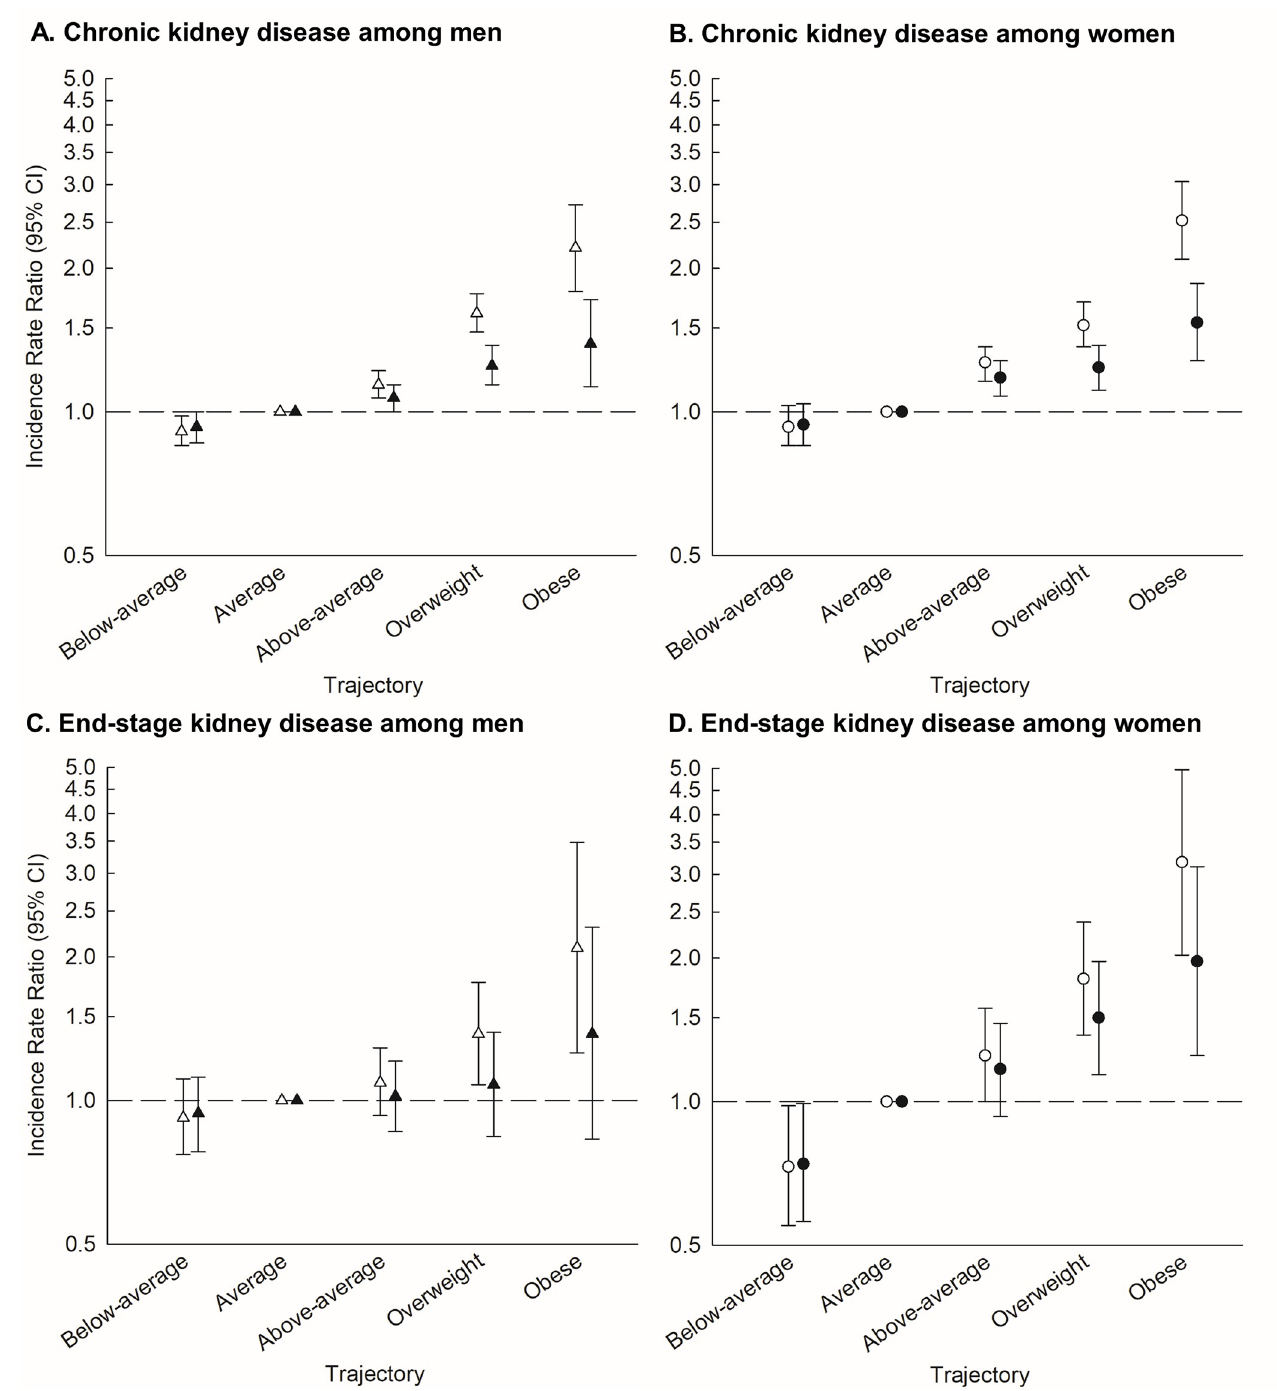
Fig 1. Childhood BMI trajectories and CKD and ESKD. (A) CKD among men in analyses without (white) and with (black) T2D. (B) CKD among women in analyses without (white) and with (black) T2D. (C) ESKD among men in analyses without (white) and with (black) T2D. (D) ESKD among women in analyses without (white) and with (black) T2D. BMI AU : AnabbreviationlisthasbeencompiledforthoseusedinFig 1 : Pleaseverifythatallentriesarecorrect : , body mass index; CI, confidence interval; CKD, chronic kidney disease; ESKD, end-stage kidney disease; T2D, type 2 diabetes.